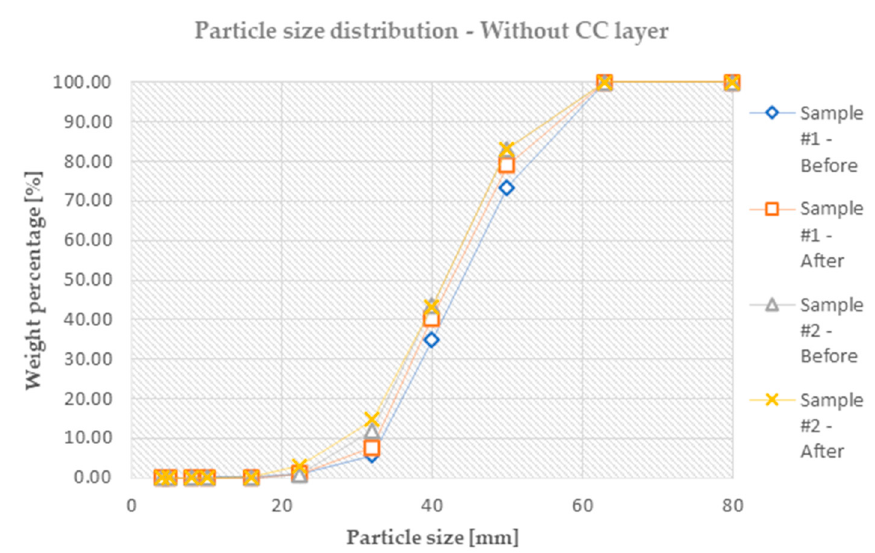
Figure 6. The particle size distribution before and after the tests for the specimens without CC layer (PSD—particle size distribution).